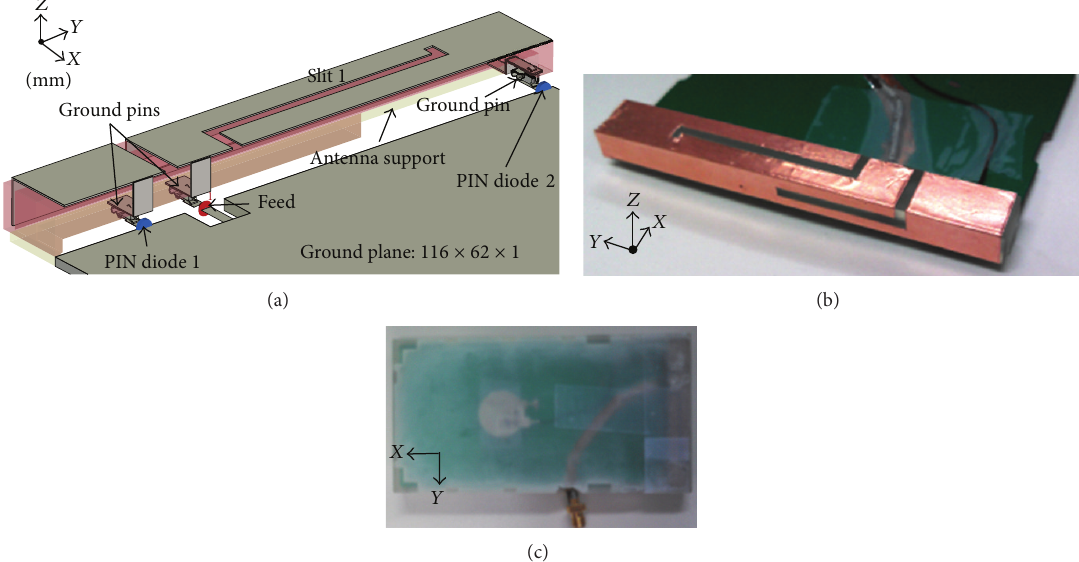
Figure 8: The structure of the proposed antenna: (a) overall view, (b) photograph of the proposed antenna without the outer housing case, and (c) photograph of the proposed antenna with the outer housing